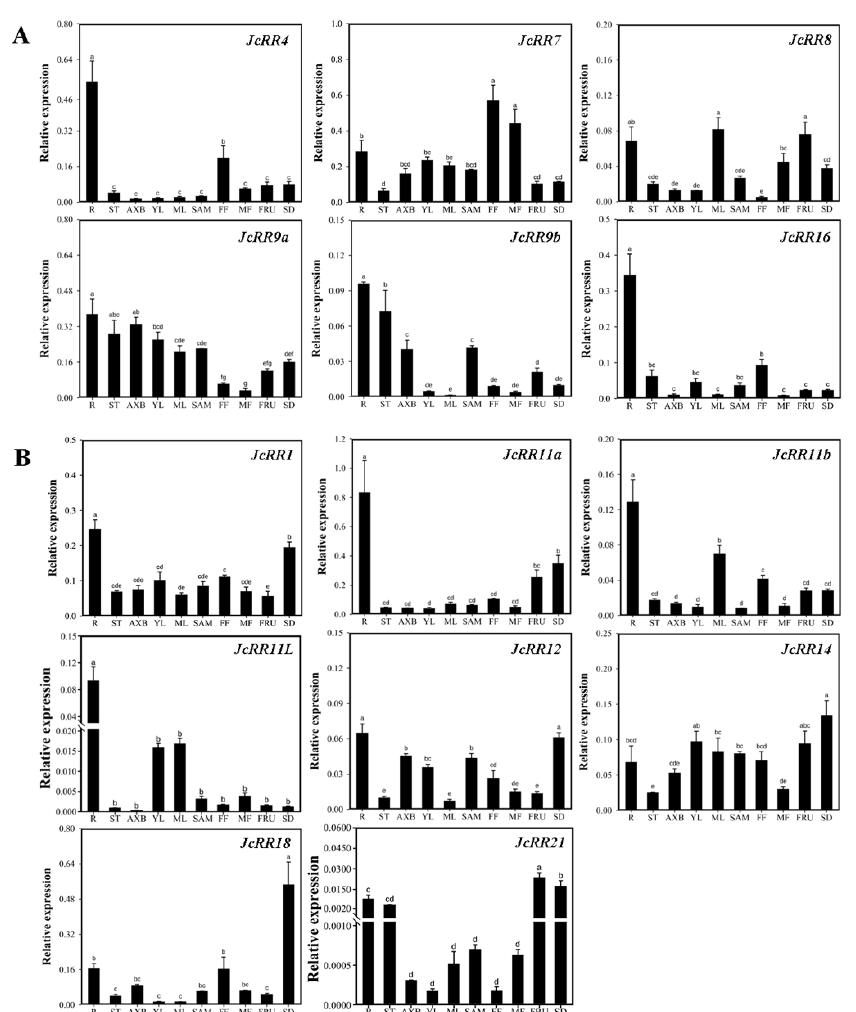
Figure 9. Expression profiles of JcRR s in various tissues, as revealed by q RT‒PCR analysis. ( A ) Expression profiles of 6 type-A JcRR s. ( B ) Expression profiles of 8 type-B JcRR s. qRT‒PCR analysis was performed on ten tissues: R, roots; ST, stems; AXB, axillary buds; YL, young leaves; ML, mature leaves; SAM, shoot apical meristems; FF, female flowers; MF, male flowers; FRU, fruits; SD, seeds. The qRT‒PCR results were obtained from three independent biological replicates and three technical replicates per sample. The error bars represent the standard deviations (SDs). Different letters indicate significant differences ( p < 0.05, n = 3, one- way ANOVA, Tukey’s test).